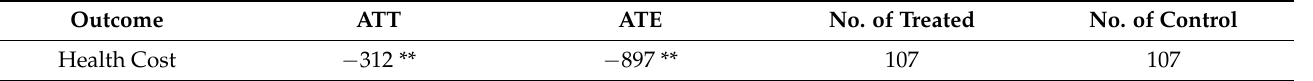
Table 8. Impact of adoption on health costs.